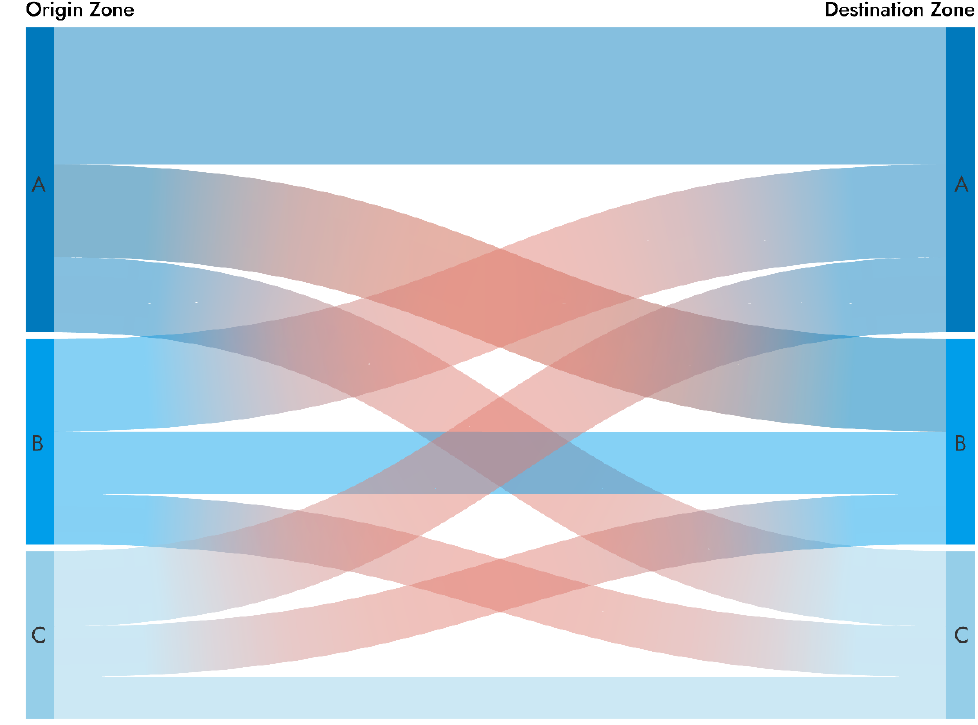
Figure 7. Sankey diagram illustrating the O-D connections in the study area.